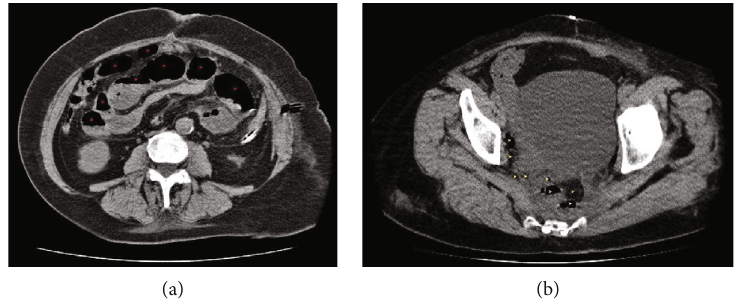
Figure 3: Patient ’ s CT scans on the 6 th postoperative day. Multiple intestinal “ levels ” of gas and fl uid throughout the abdominal cavity were observed ((a), red arrowheads). Part of the distal intestinal loop with di ff erence in lumen diameters was situated at the level of the pelvic fl oor ((b), yellow arrowheads) and was adherent to both rectal and vaginal stumps.